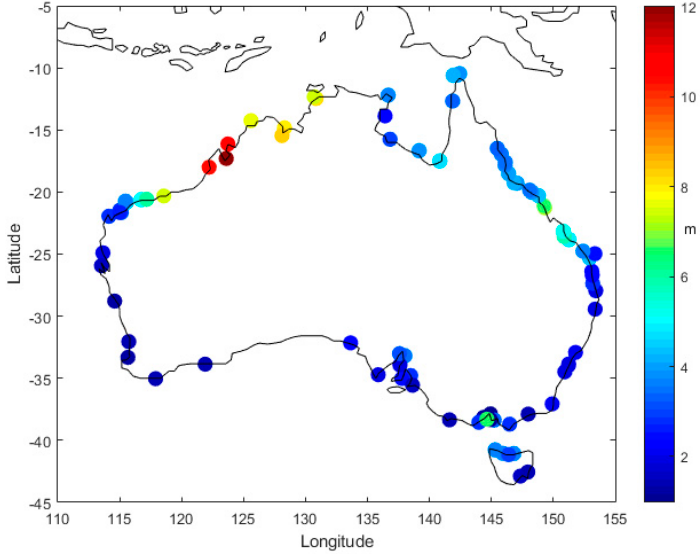
Figure 1. Highest astronomical tides (HATs) observed around Australia in 2018. Circles indicate locations of tide gauges around locations of tide gauges around coastlines.